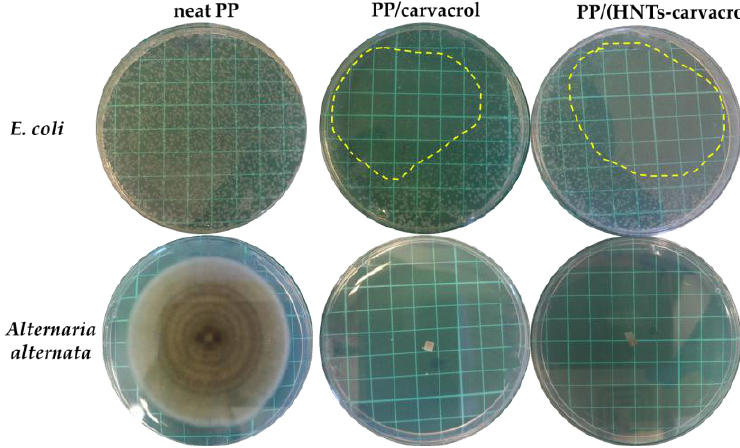
Figure 6. Antimicrobial effect of neat PP, PP/carvacrol and PP/(HNTs-carvacrol) films exhibited in the micro-atmosphere diffusion assays, i.e., without direct contact between the studied films and the microbial cultures. Top panel : Petri dishes containing the E. coli after incubation with the films for 12 h, at 37 °C (the margins of the inhibition zone are marked for clarity). Bottom panel : Petri dishes containing A. alternata following seven days of incubation, at 25 °C, in the dark.